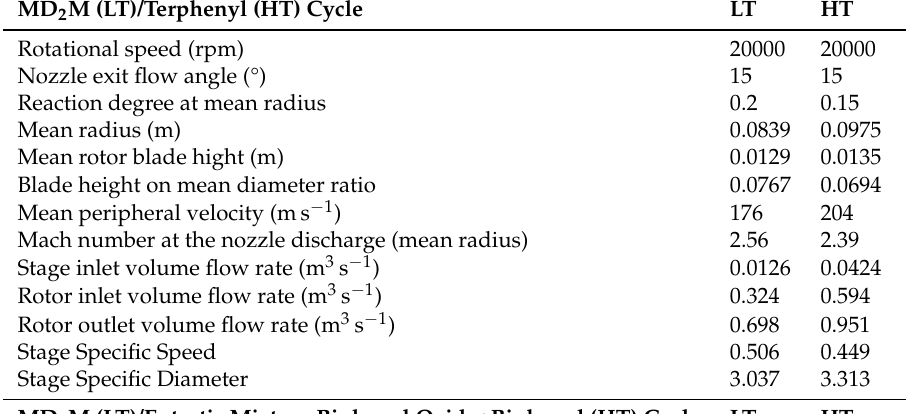
Table 5. Some calculated approximate geometrical turbine features for the binary